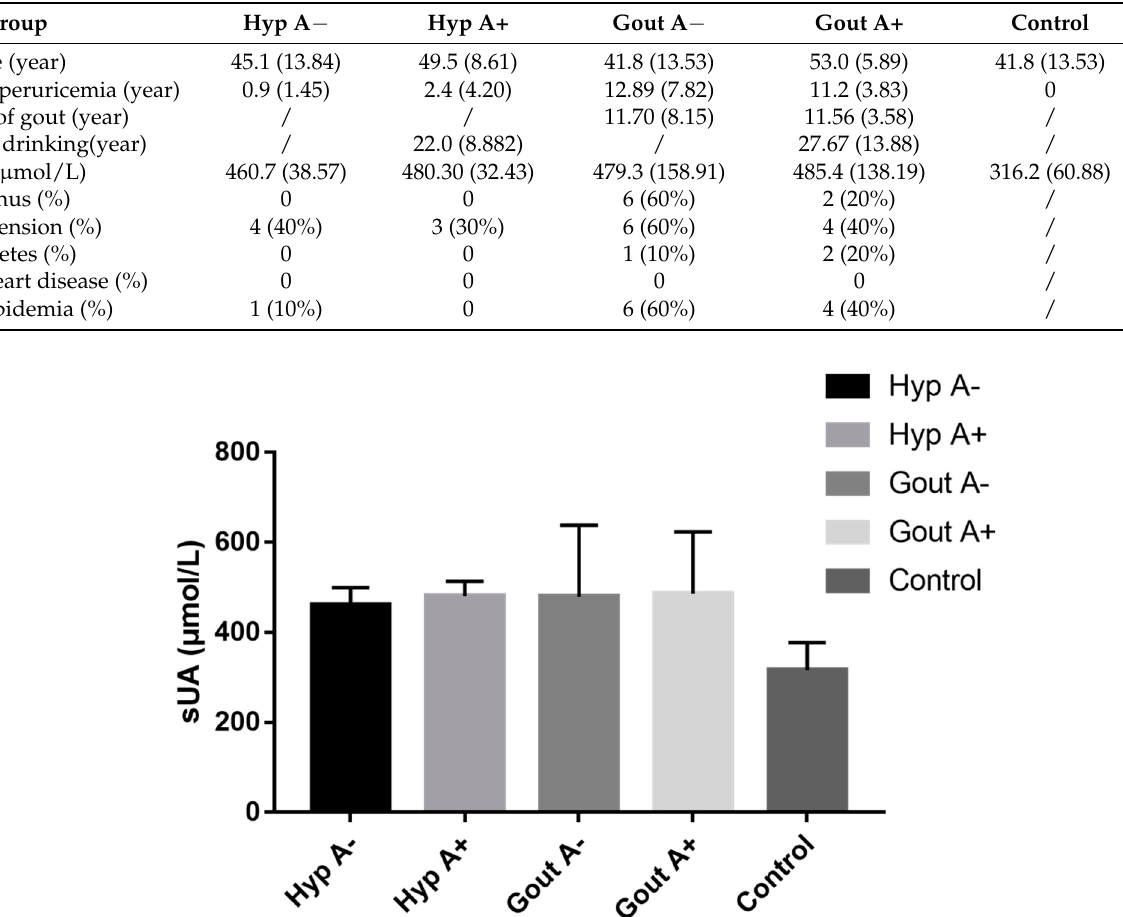
Table 2. Characteristics of individuals included in the serum uric acid analysis, − /+ refer to the alcohol consumption status, for example Hpy A − would refer to the group with hyperuricemia which does not consume in alcohol.